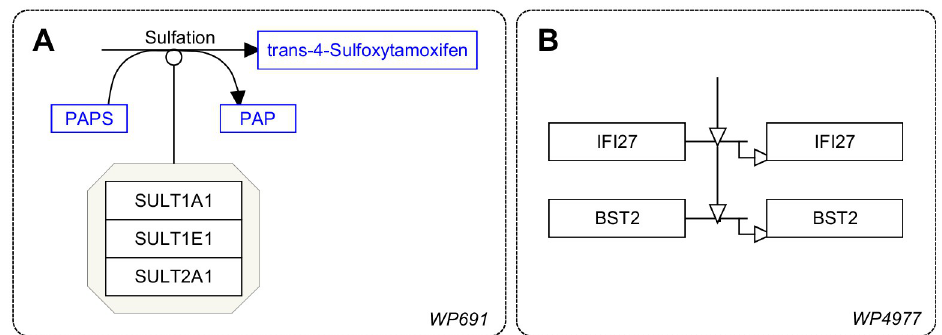
Fig 2. Interaction types that are not found in Table 6. A shows a complex binding of SULT1A1, SULT1E1 and SULT2A1 that catalyzes cis-4-hydroxytamoxafin to trans-4-sulfoxytamoxifen with PAPS to PAP formation found in Tamoxifen Metabolism (wikipathways:WP691). B shows transcription translation interaction for BST2 to BST2 in Host-pathogen interaction of human corona viruses—MAPK signaling pathway